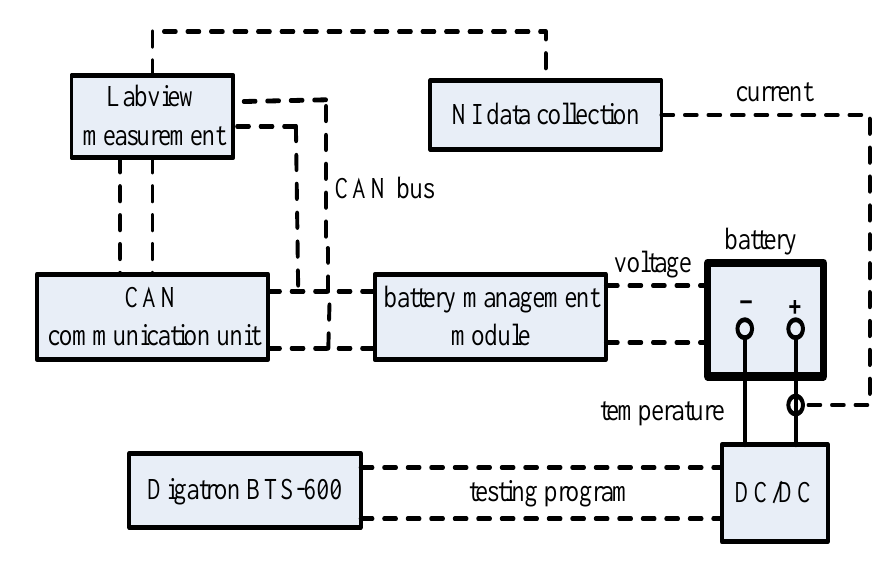
Figure 2. Configuration of battery test